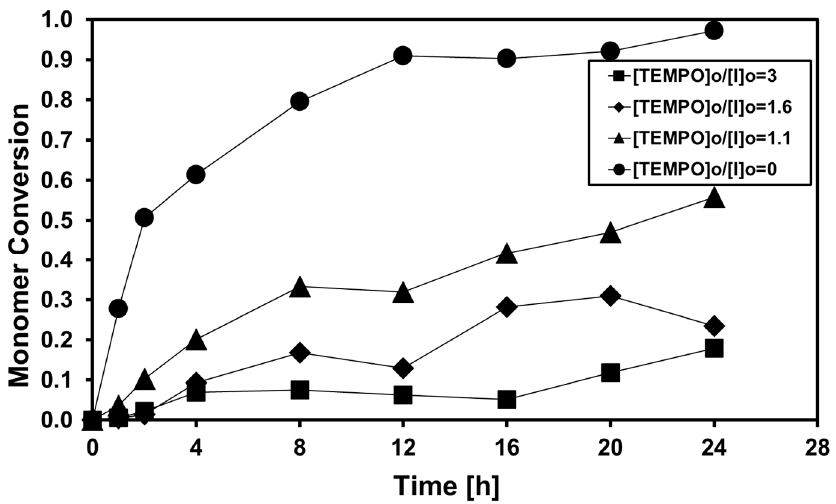
Figure 8. Effect of controller (TEMPO) content on polymerization rate for the NMC of STY/DVB in scCO 2 at [DVB] = 1 wt.%, T = 120 °C, and P = 207 bar.